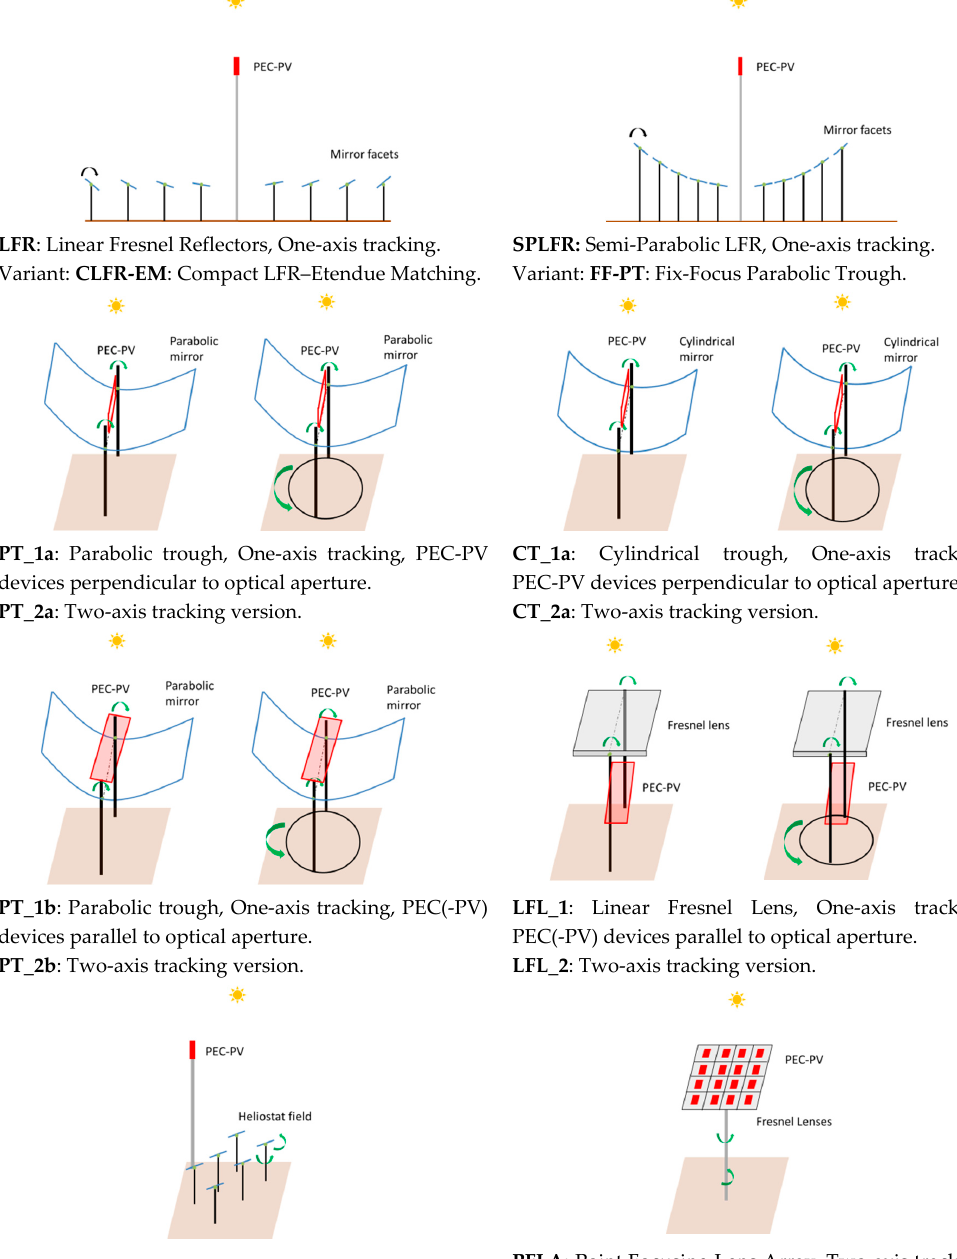
Figure A3. Illustration of design concepts listed in Table 4.